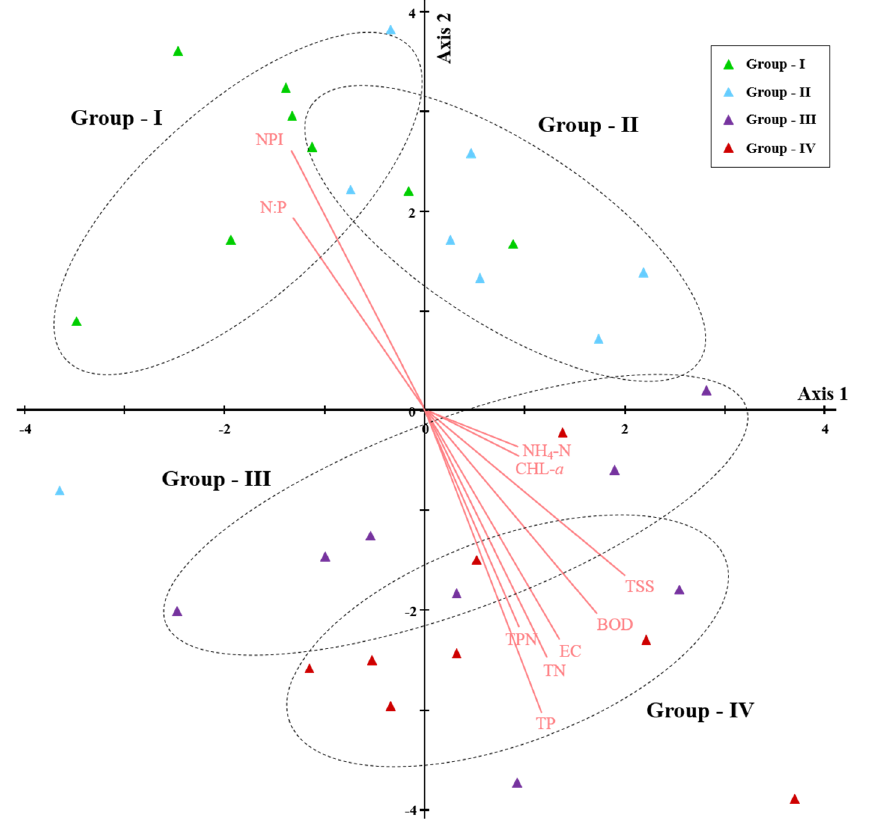
Figure 3. Principal component analysis (PCA) based on biological components (% tolerant species, % sensitive species, % omnivores, % insectivores, IBI value) and chemical